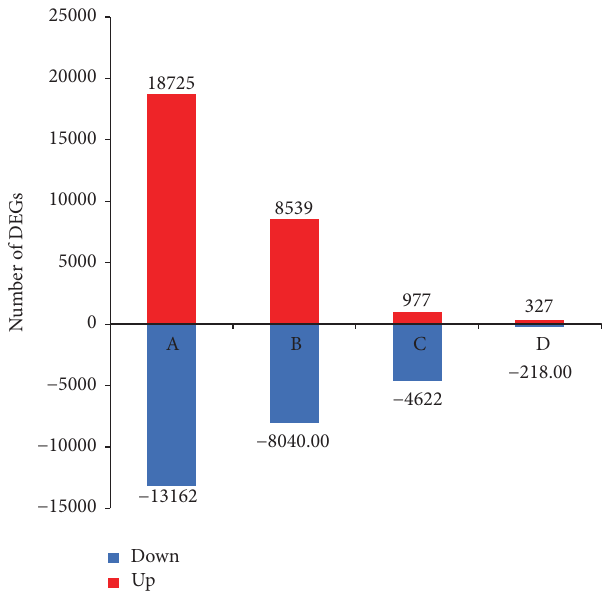
Figure6:Numbersofup-(red)anddownregulated(blue)unigenes. The numbers on column indicate the quantity of up- (red) and downregulated (blue) genes. The results of four comparisons are shown. The signal intensities of each feature of the DEGs are plotted on a logarithmic scale. Statistical criteria for designation of genes as up- or downregulated are outlined in the methods.